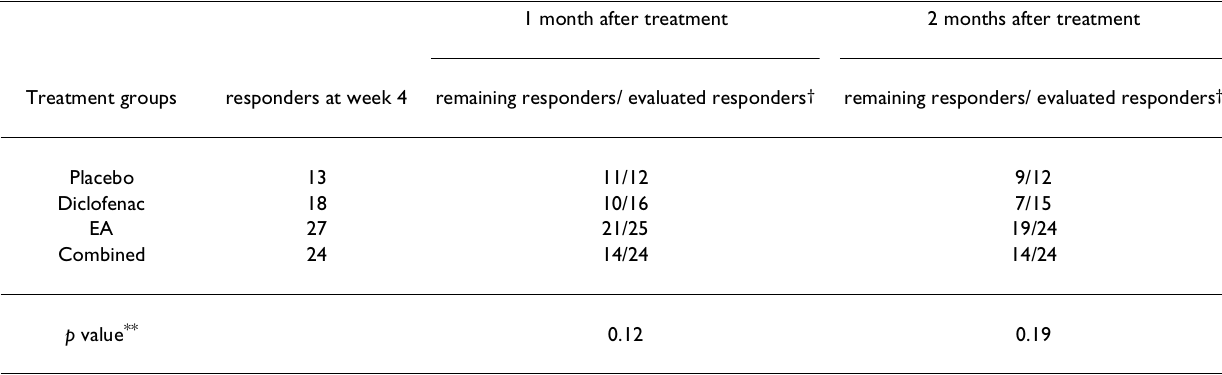
Table 6: Number of responders considered at the end of the study (week 4) and at 1 and 2 month(s) after treatment * . 1 month after treatment 2 months after